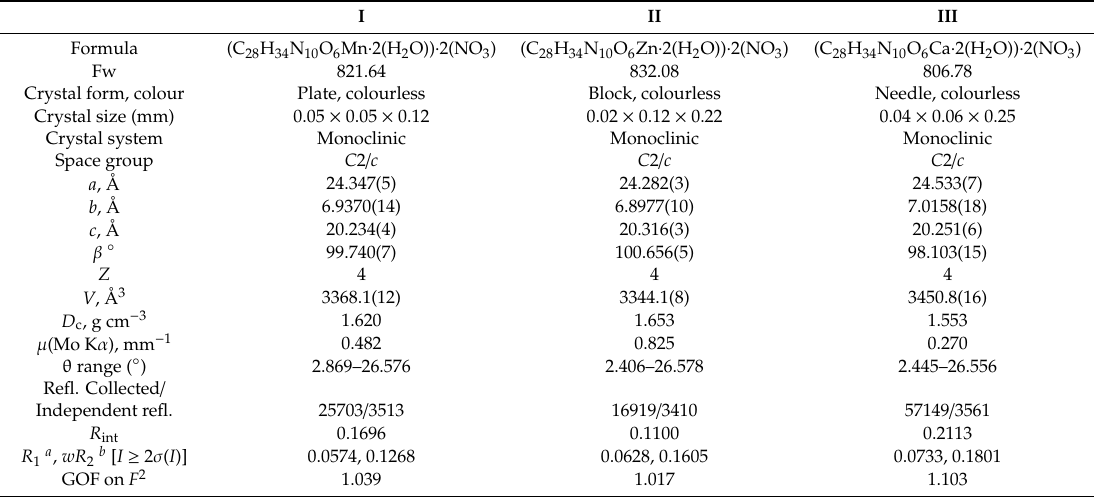
Table 5. Crystal data and structure refinement information for complexes I – III